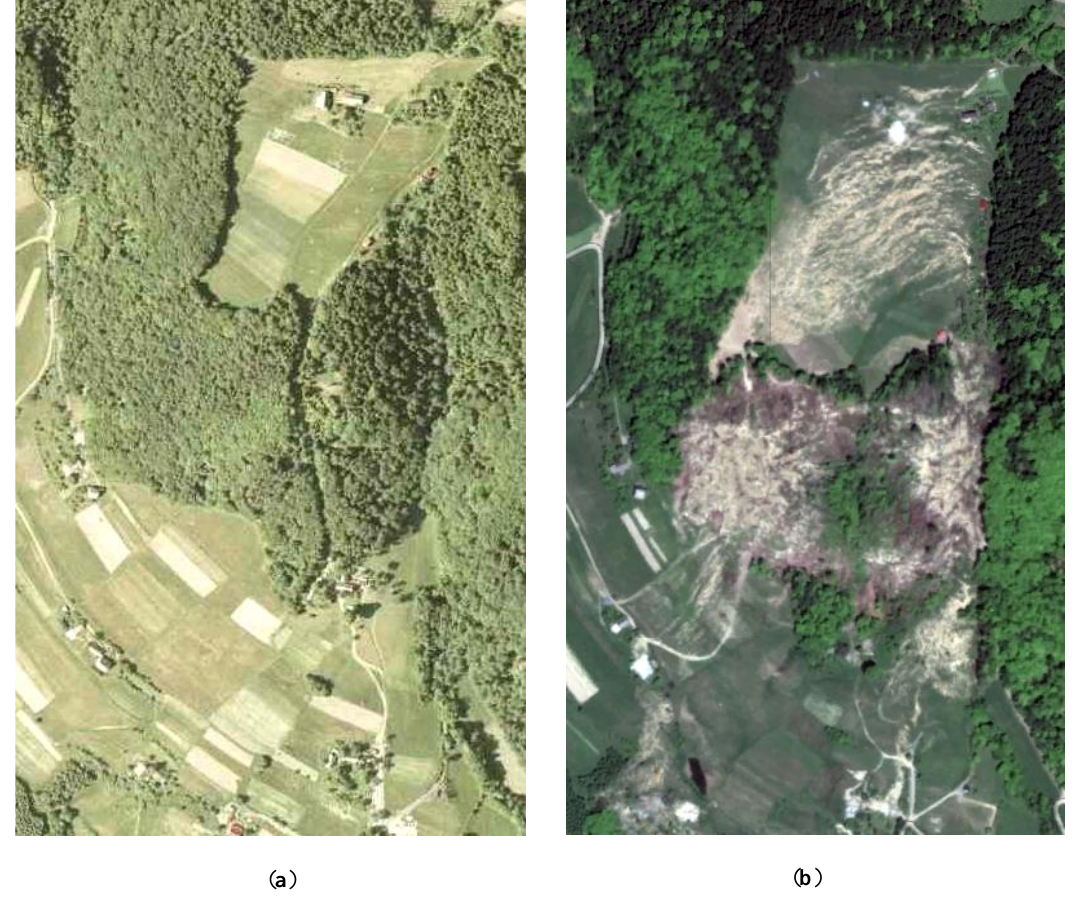
Figure 2. Survey site: ( a ) April 2010 — before landslide [62]; ( b ) October 2014 — after landslide [63].